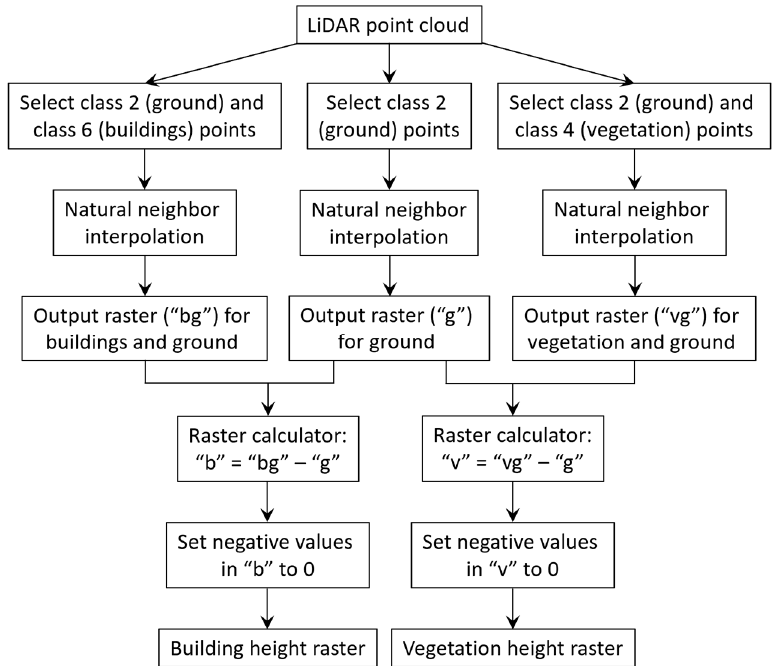
Figure 4. Flowchart for Light Detection and Ranging (LiDAR) data processing. Int. J. Environ. Res. Public Health 2020 , 17 , x